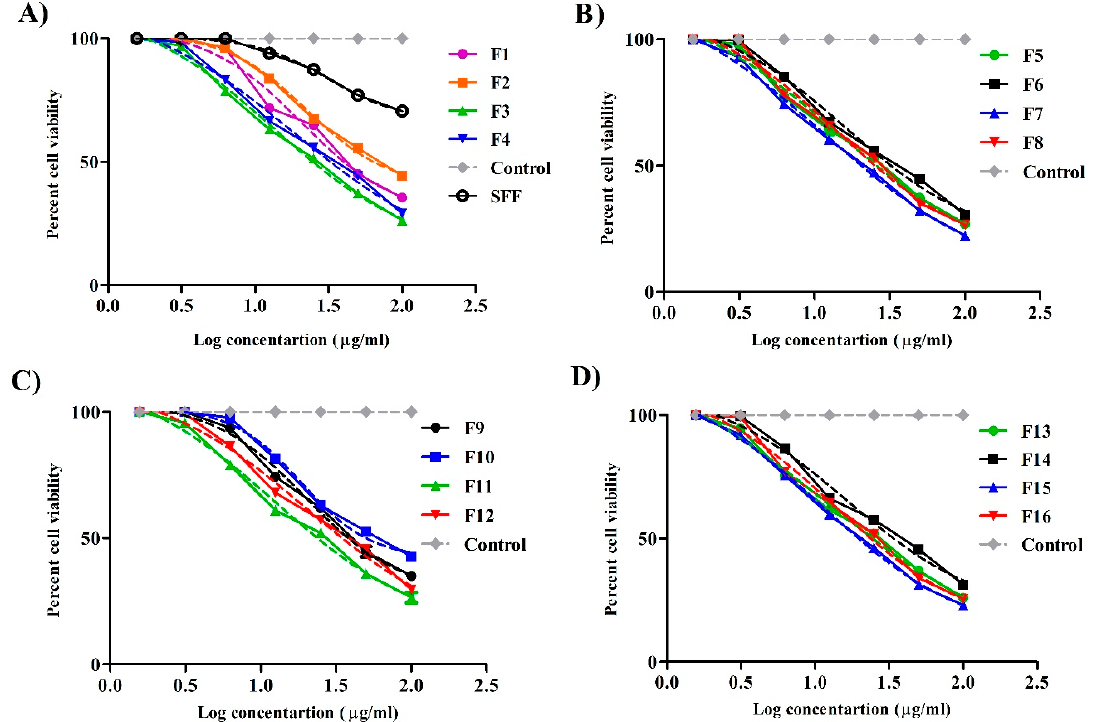
Figure 7. Percentage of cell viability of WI-38 cell line incubated with culture media (control) and different concentrations of stabilizer free formulation (SFF) and all other investigated formulations (( A ), for F1–F4; ( B ), for F5–F8; ( C ), for F9–F12; ( D ), for F13–F16) after 48 h by MTT assay ( n = 3). Continuous lines represent the actual curves of the original values while dashed lines represent curves after a non-linear fit of data of corresponding colors.